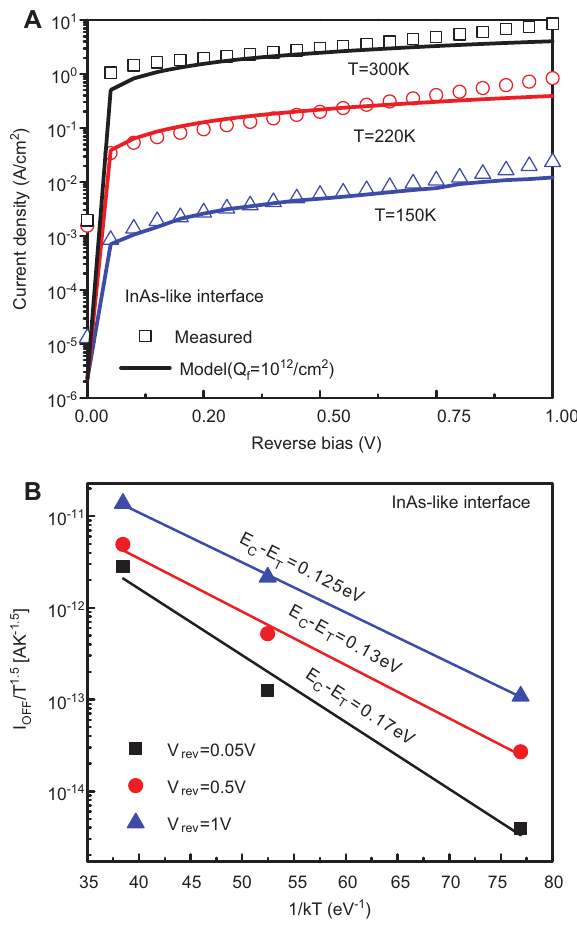
Figure 26 (A) Measured and simulated I-V characteristics of reverse-biased InAs-like interface GaAs